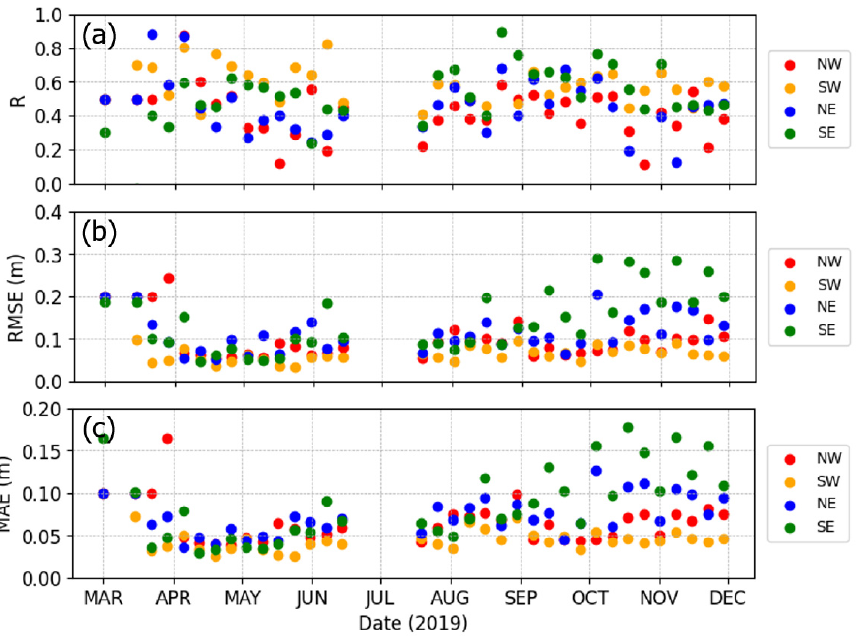
Figure 7. Temporal variations of cross-validation parameters for each geographical subsector (NW, SW, NE, and SE): ( a ) R, ( b ) RMSE, and ( c ) MAE.